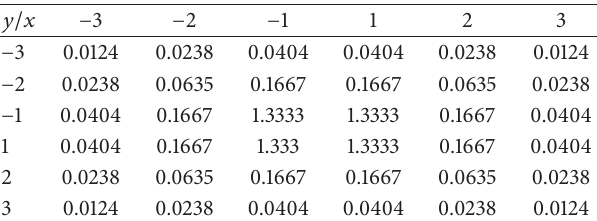
Table 1: Positive surface data set.